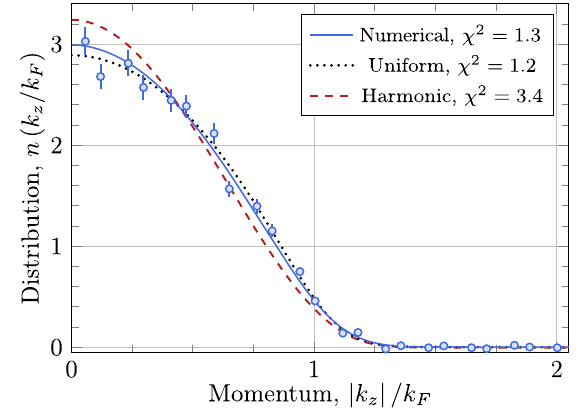
FIG. 4. The one-dimensional momentum distribution of a uniform periodically driven Fermi gas. The distribution, mea- sured by Raman spectroscopy [53], is fitted with three models: a numerical model that provides a realistic description of the flat trap in the experiment (solid blue line; see Appendix A), an ideal homogeneous Fermi-Dirac distribution given by Eq. (18) (dotted black line), and a harmonically trapped gas (dashed red line). The numerical and homogeneous models yield a better fit to the data than the harmonic one, based on the χ 2 values. The differences between the uniform and numerical models are not significant. The temperature extracted from the numerical model is T=T 0 . 15 ð 1 Þ with T ¼ 7 ð 2 Þ nK. The results of the other fits are discussed in the main text. This measurement is performed at a magnetic field of B ¼ 209 . 18 G, where the atoms are very weakly interacting. The rf pulse duration is 200 ms with a Rabi frequency of Ω = 2 π ≈ 10 . 5 kHz. Error bars represent one standard deviation of the measured values.